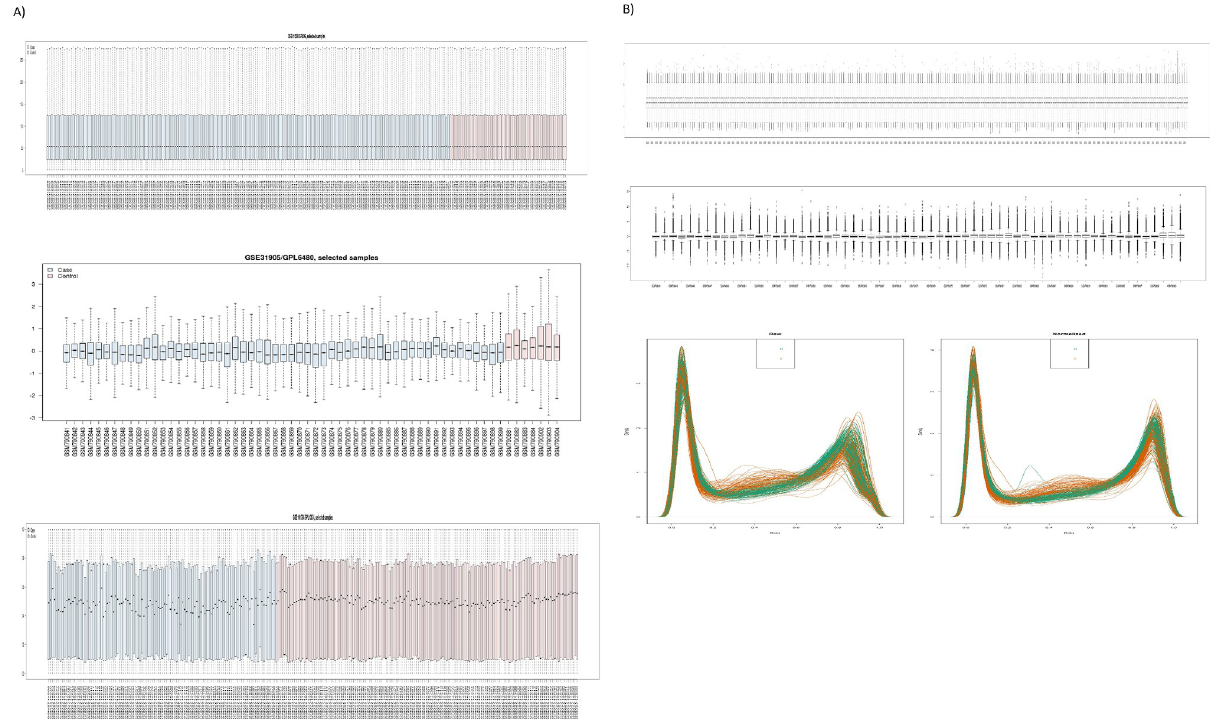
Fig 1. A) Box plots of pre-processed samples data in GEO2R. The top Box plots relate to the discovery dataset. The middle Box plots pertain to the validation dataset. The bottom Box plots are for the methylation dataset. B) Post-processed (Normalized) samples data. The top Box plots relate to the discovery dataset. The middle Box plots pertain to the validation dataset. The bottom left plot is for the methylation dataset raw data. The bottom right plot is for the methylation dataset normalized